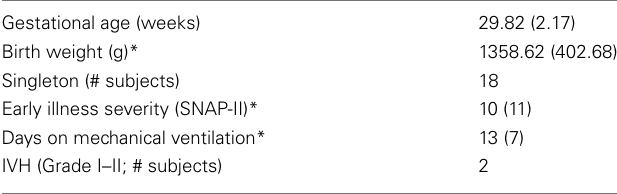
Table 1 | Neonatal characteristics of the very preterm